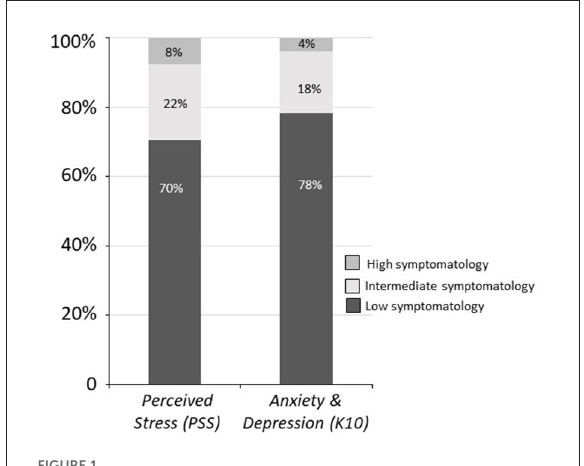
FIGURE1 Frequencies of COVID-19 patients showing high, intermediate, and low symptomatology on the K10 and PSS (anxious-depressive symptoms and perceived stress) at